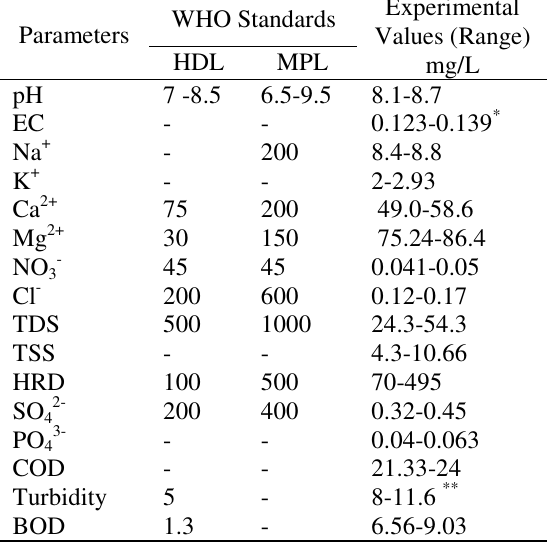
Table.1. The average values of physico-chemical parameters of Kosi River